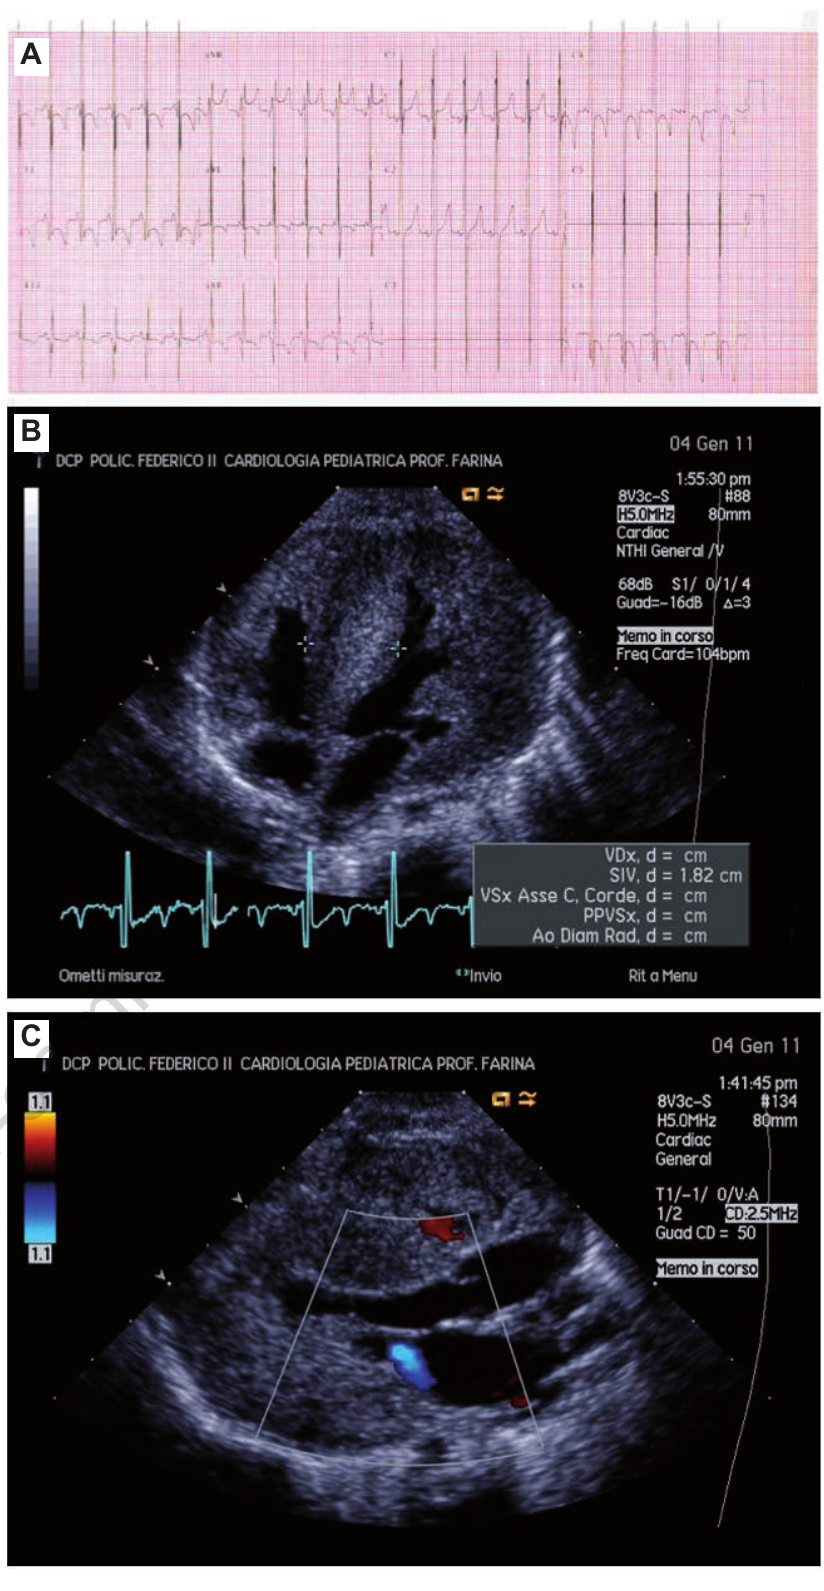
Figure 1. Patient No. 3: Severe, infantile hypertrophic cardiomyopathy (HCM) with sys- tolic dysfunction, on diuretics and ace-inhibitors. Enzyme replacement therapy started late (6 months of life). The patient died for heart failure before 1 year of age. A) Electrocardiogram showing short PR, left ventricular hypertrophy and negative T waves in precordial leads. B and C) Severe, biventricular HCM with systolic dysfunction and mitral